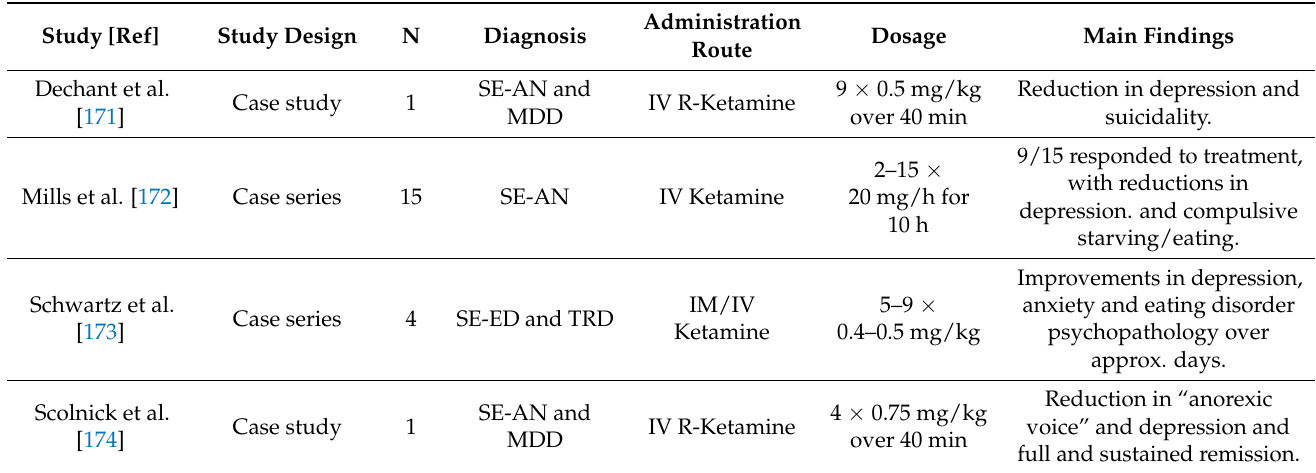
Table 2. Characteristics and main findings of studies of ketamine as a treatment for patients with eating